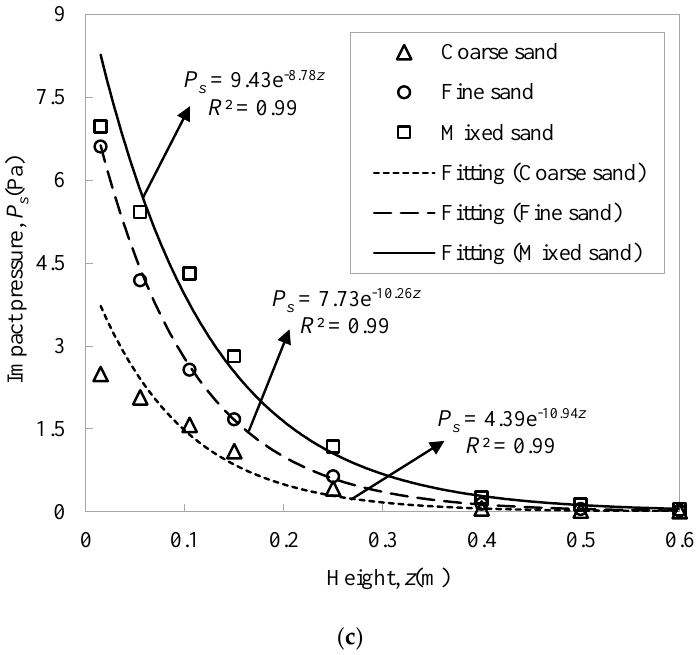
Figure 15. The impact pressure: ( a ) At the indicated wind speed of 14.74 m/s; ( b ) At the indicated wind speed of 16.68 m/s; ( c ) At the indicated wind speed of 18.61 m/s.